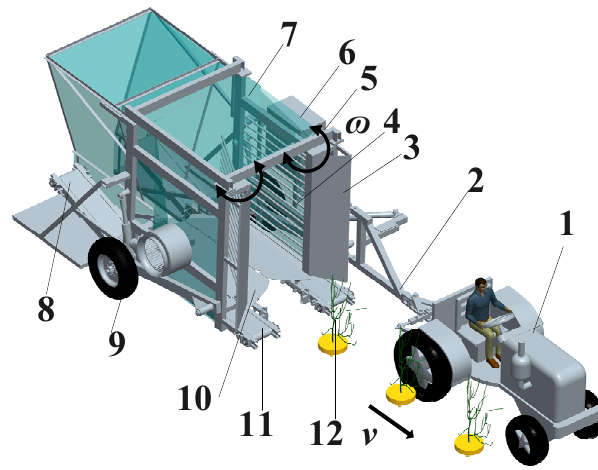
Figure 2. Structure and working diagram of the blueberry harvester. 1. tractor; 2. traction device; 3. gathering device; 4. finger rows; 5. hydraulic motor; 6. hydraulic system; 7. gantry frame; 8. inclined conveyor; 9. running system; 10. fruit catching device; 11. horizontal conveyor; 12. blueberry plants. Note: 𝑣 is the machine velocity of the harvester, (m/min); 𝜔 is the angular velocity of the swing of the finger rows, (r/min).